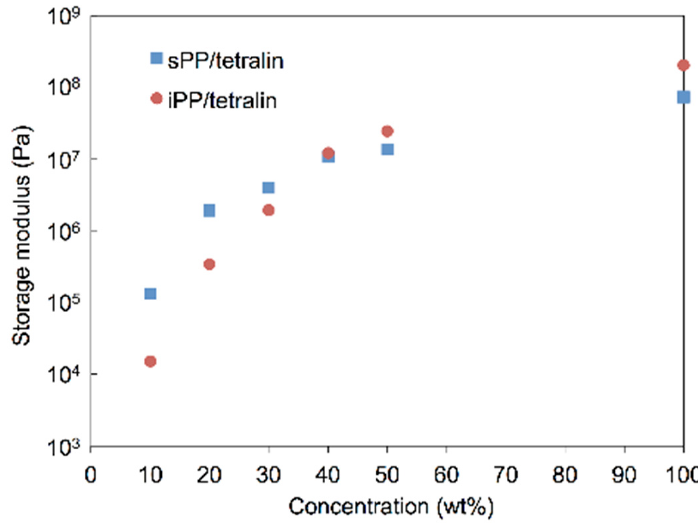
Figure 4. Storage modulus of PP-gels at 40 ◦ C as a function of the concentration of PP.